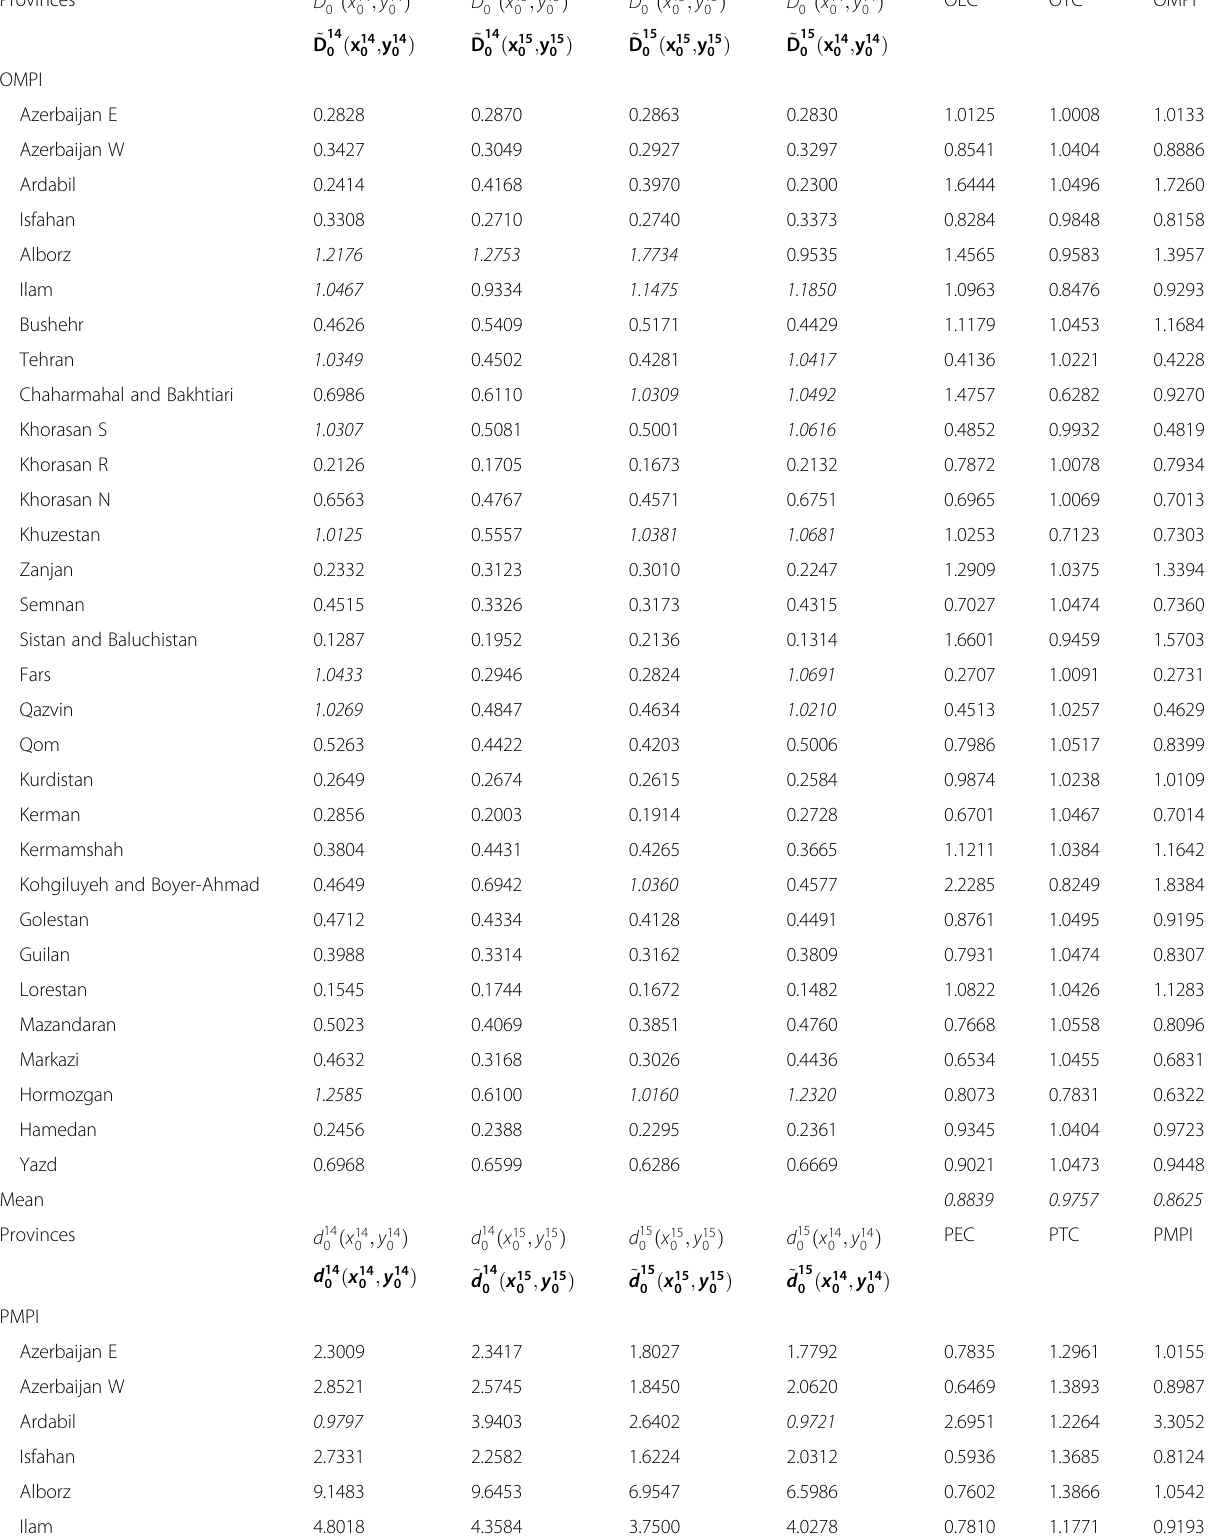
Table 7 OMPI and PMPI values for the 31 Iranian provinces (2014-2015)